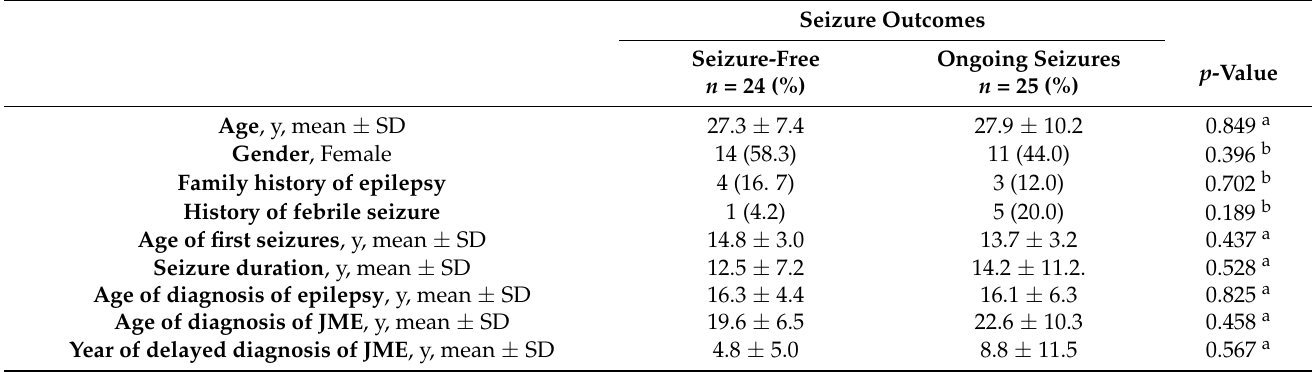
Table 2. Clinical factors distinguishing patients with and without seizure control for at least one